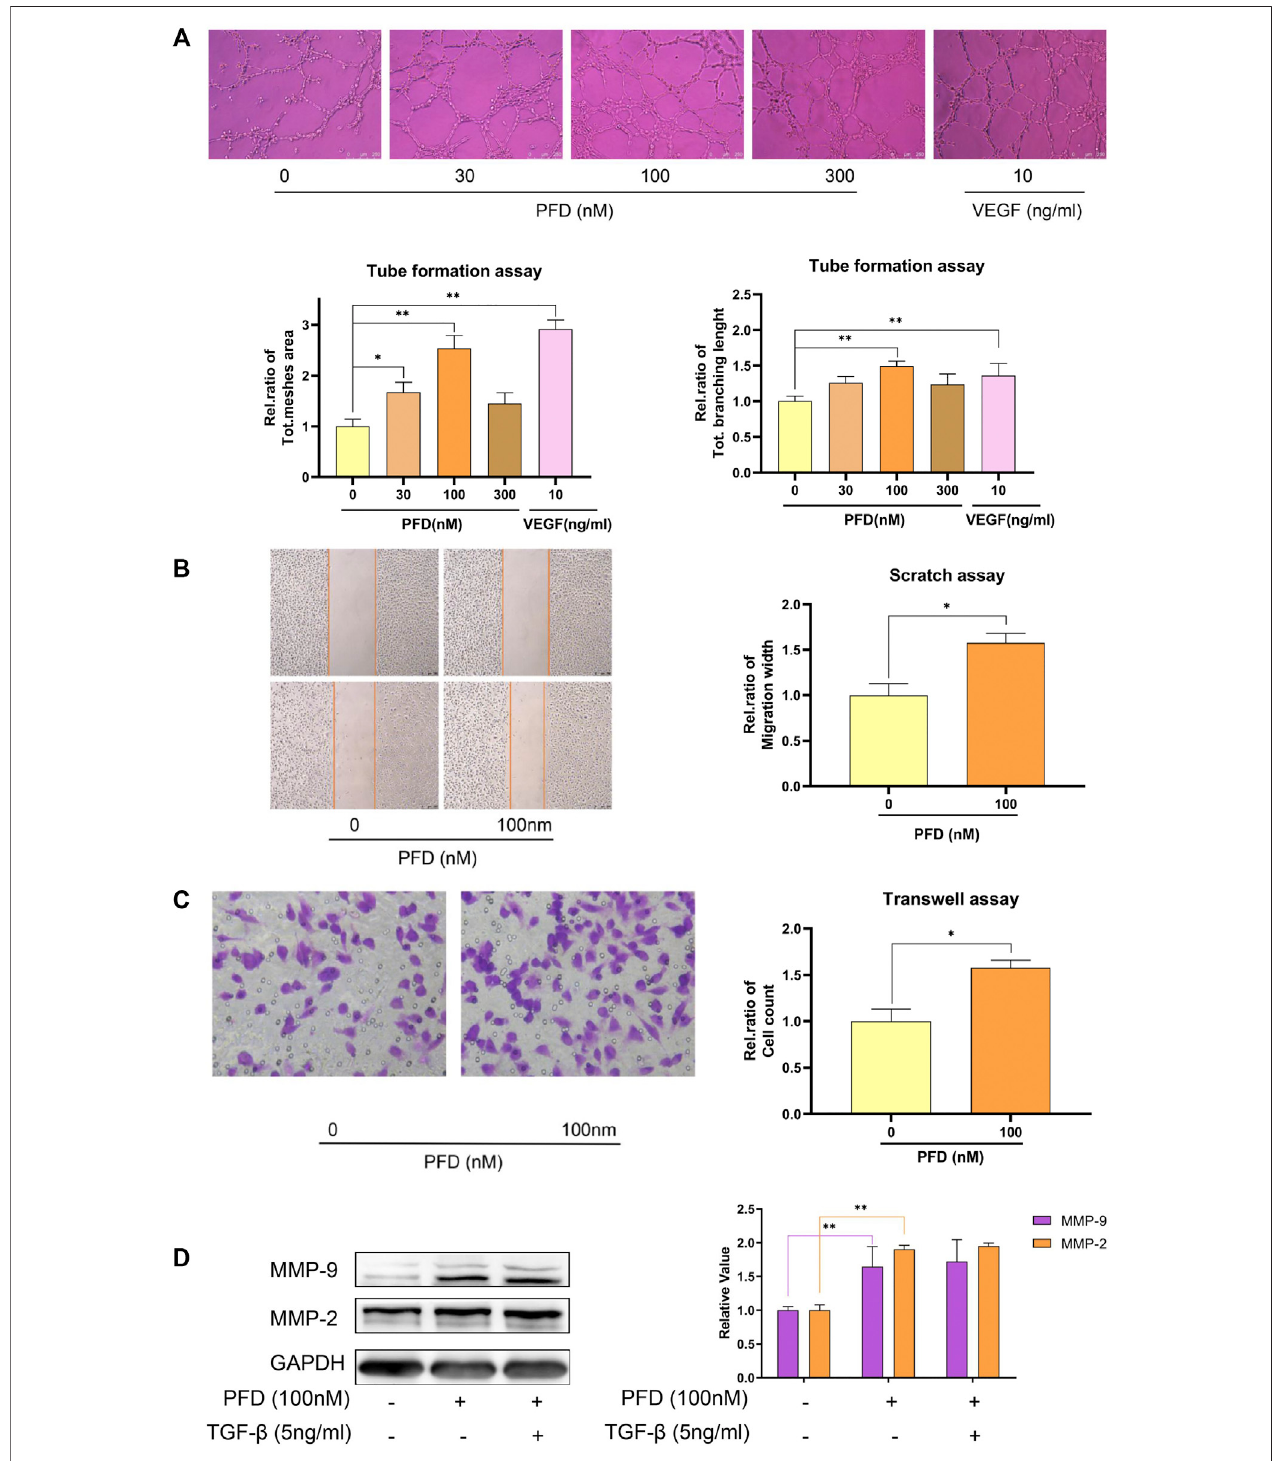
FIGURE4| LowconcentrationsofPFDpromotematrigeltubeformationandcellmigration. (A) DeterminingtheoptimalconcentrationofPFDtopromotematrigeltube formation in EA.hy926 cells; (B) PFD promotes the recovery of the scratch width of EA.hy926 cells; (C) PFD promotes the transwell migration of EA.hy926 cells; (D) low concentrations of PFD promoted the expression of MMP-2 and MMP-9 proteins, which could not be reversed by TGF- β protein. * p < 0.05; ** p < 0.01.